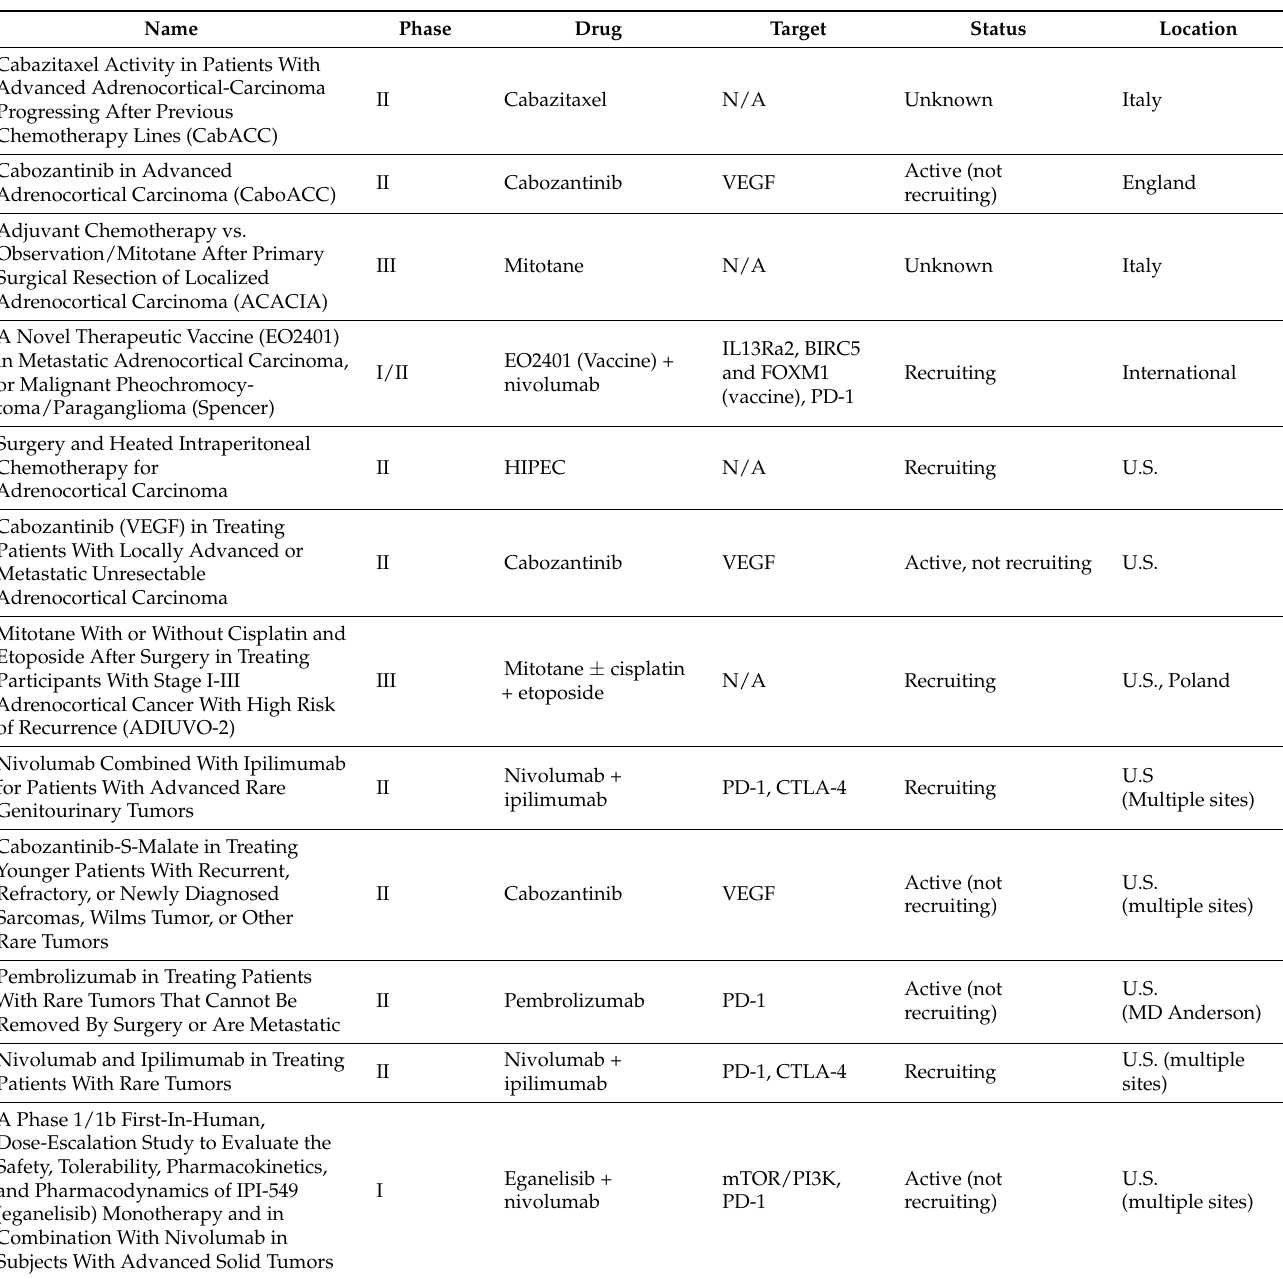
Table 1. Ongoing clinical trials for the treatment of ACC (from the ClinicalTrials.gov